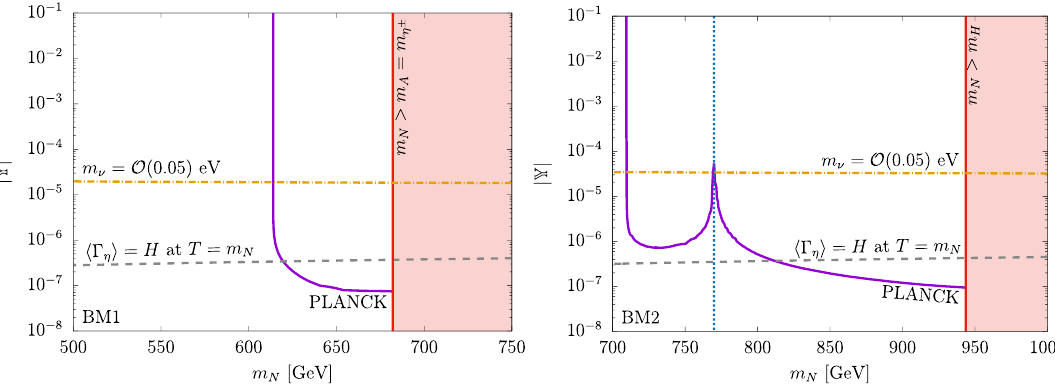
Figure 9 . Parameter space in the ( m N , | Y | ) plane for BM1 (left) and BM2 (right). The purple lines can reproduce the observed relic abundance. In the red regions on the right-handed side, the dark matter candidate N becomes heavier than the inert scalars. The orange dashed-dotted line corresponds to the order of the neutrino Yukawa coupling which can predict the correct small neutrino mass scale O (0 . 05) eV . The vertical blue dotted line around m N ∼ 770 GeV in the right panel corresponds to the threshold m N = m η for T & T n . The gray dashed lines the lines of h Γ η i = H at T = m N